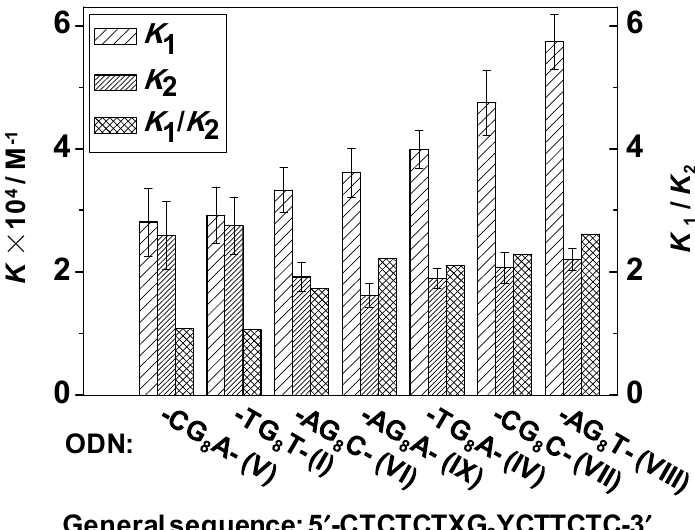
Figure 3. Sequence selectivity of organometallic ruthenium complex 4 binding to single-strand ODNs I and IV – IX . K 1 and K 2 , of which the values are listed in Table S2 in supplementary materials, are the binding constants of complex 4 to each ODN at the first and the second step of binding, respectively.